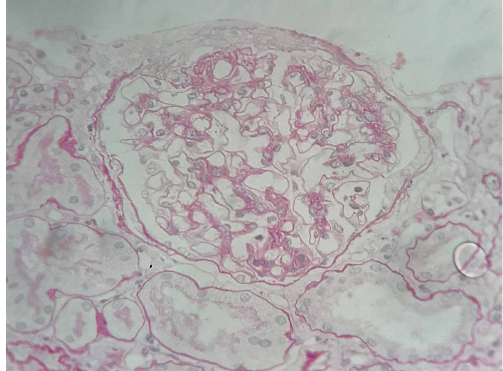
Figure 2: Mesangial proliferative glomerulonephritis was demonstrated (PAS stain).